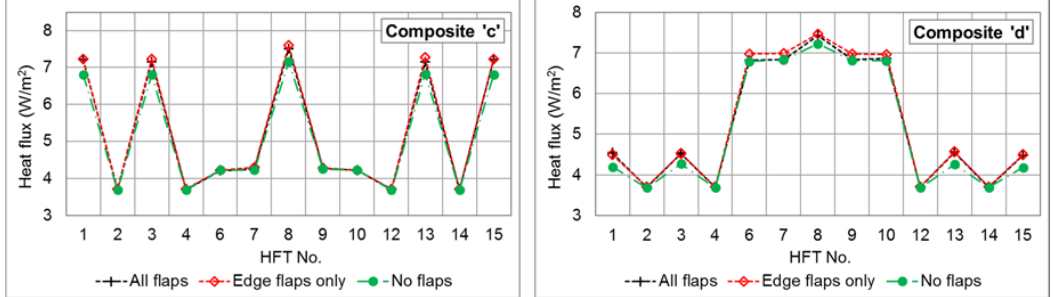
Figure 10. Comparison of simulated heat fluxes with ‘All flaps’, ‘Edge flaps only’ and ‘No flaps’.